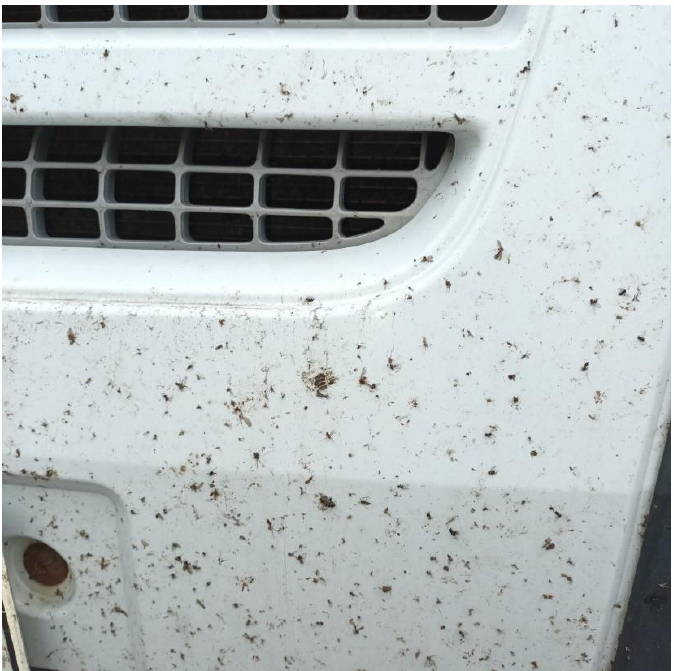
Figure 1. Insects (at least Culicidae, Mycetophilidae and Simulidae; identification by Dr. Jukka Salmela) smashed on the front panel of a car in the city of Rovaniemi, Finland (6 September 2022; Photo J. Jokimäki).